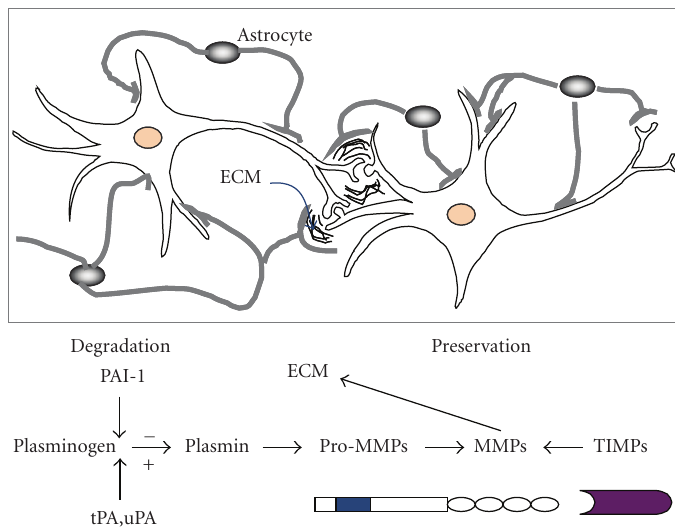
Figure 1: Diagram describing the influences of PAI-1, tPA/uPA, plasminogen and plasmin upon the conversion of pro-MMPs to active MMPs. Many active MMPs function to degrade the ECM; while TIMPs are designed to deactivate the MMPs thus preserving ECM molecules and connections. Modified from Wright and Harding [29] (potential contributions in the areas of memory consolidation, reconsolidation, and